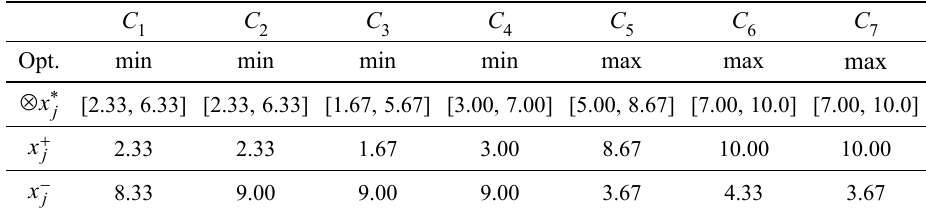
Table 6. The grey ideal point and largest and smallest performance